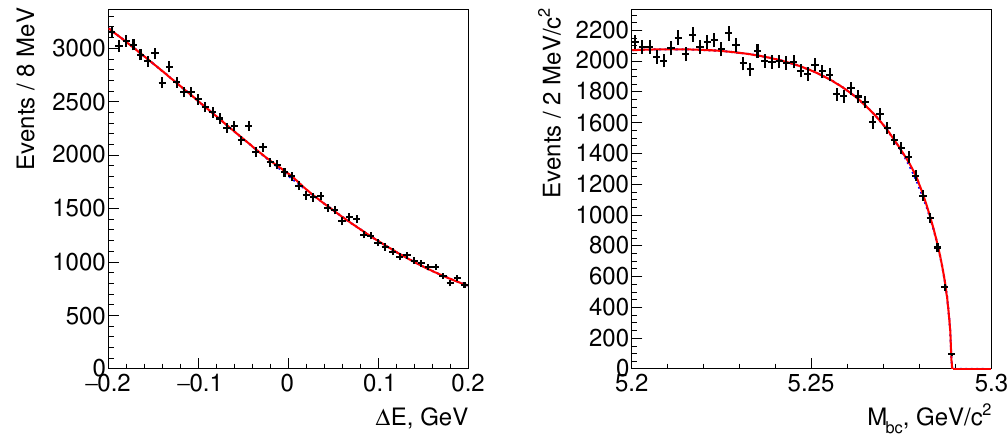
Figure 2 . Projections of the results of the (cid:12)t to the ((cid:1) E; M bc ) distribution onto (cid:1) E